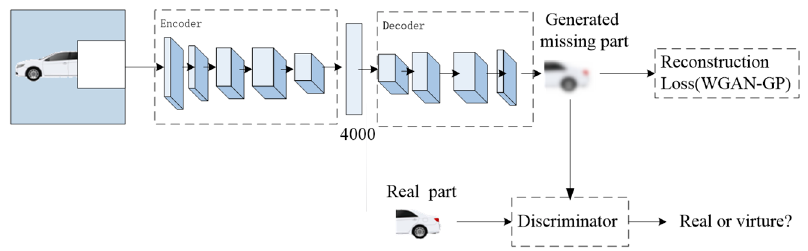
Figure 5. The architecture of the image inpainting network by GAN.